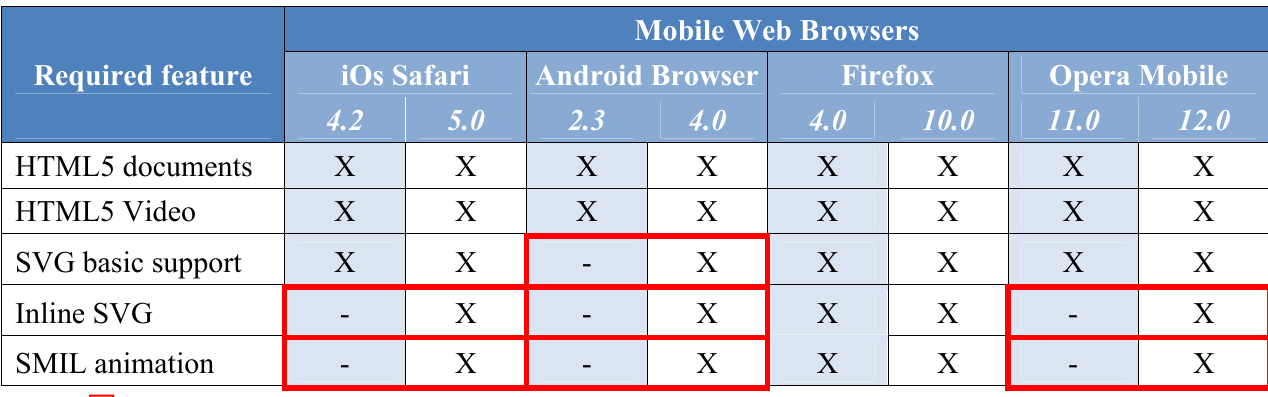
Table 2. Support of the major mobile web browsers for the proposed solution in. For each browser, the left-hand column indicates the support of the browser version available during our previous study (conducted in mid-2011) and the right-hand column indicates the support provided by the current browser version (in early